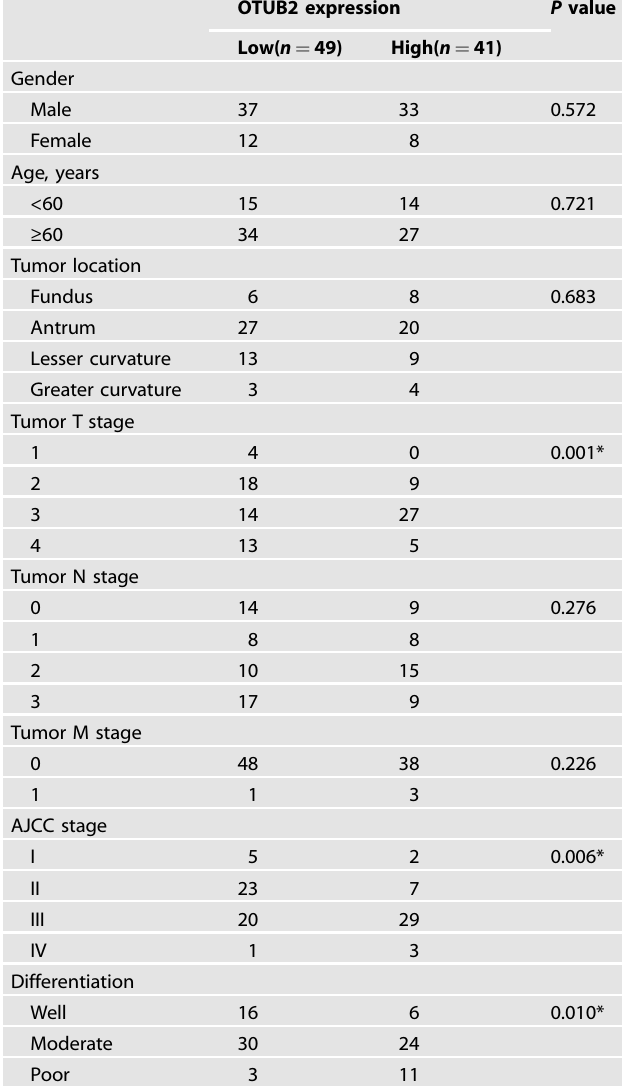
Table 1. Association between clinicopathological parameters and OTUB2 expression ( n =